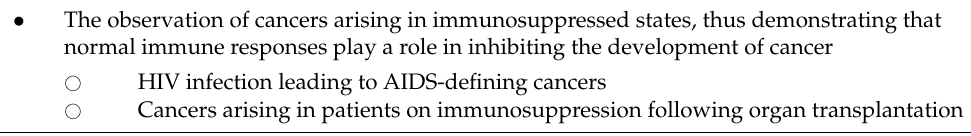
Table 2. Rationale for the Potential Success of Immunotherapy of Chronic Viral Infections and